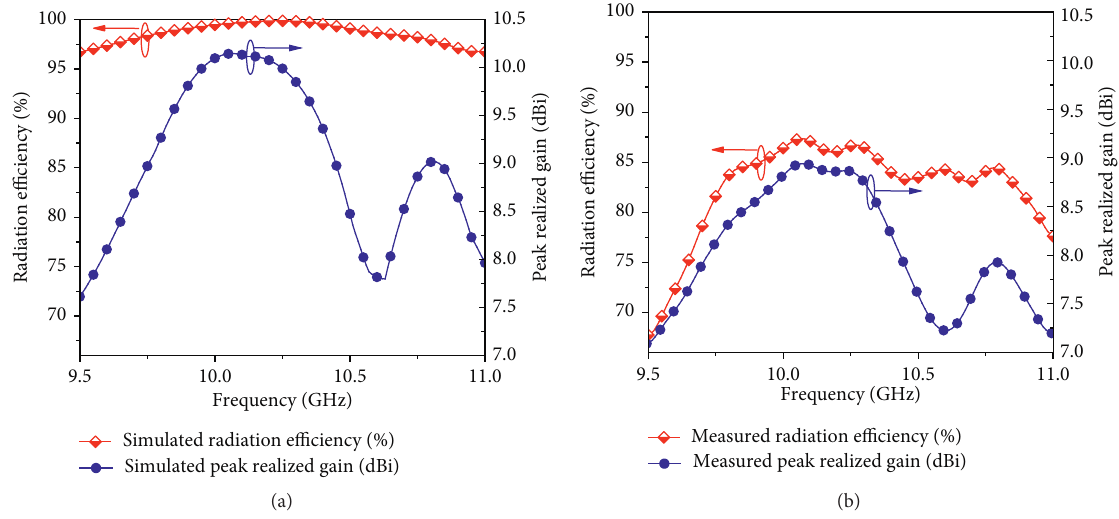
Figure 8: Radiation efficiency and peak realized gain over the operable frequency span (GHz). (a) Designed model. (b) Fabricated